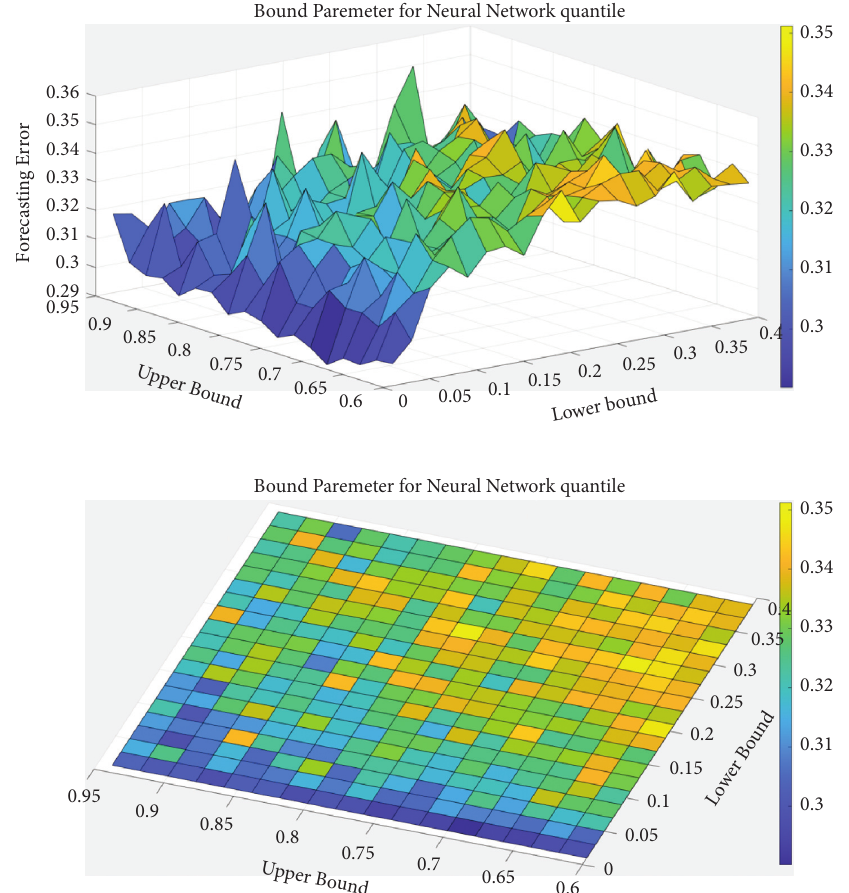
Figure 10: Grid optimization results of quantile parameters on both sides.